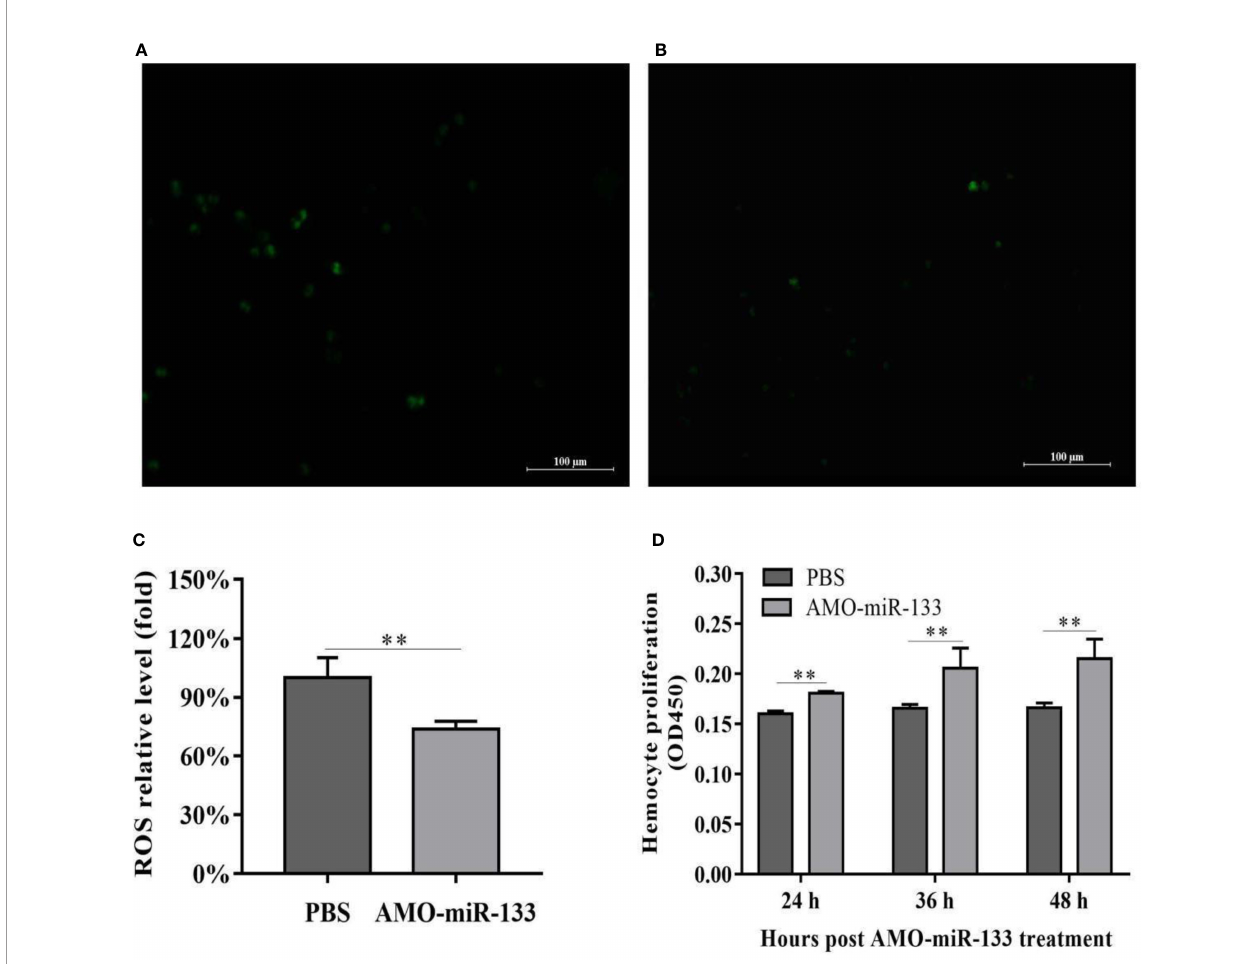
FIGURE 5 | ROS activity andproliferation of hemocytes. (A) PBS group. (B) AMO-miR-133 group. (C) ROS activity columnar statistical chart. (D) Hemocyte proliferation columnar statistical chart. Barsrepresent the meansof three individual means± SD. Signi fi cant difference between different samples isindicated by** P <